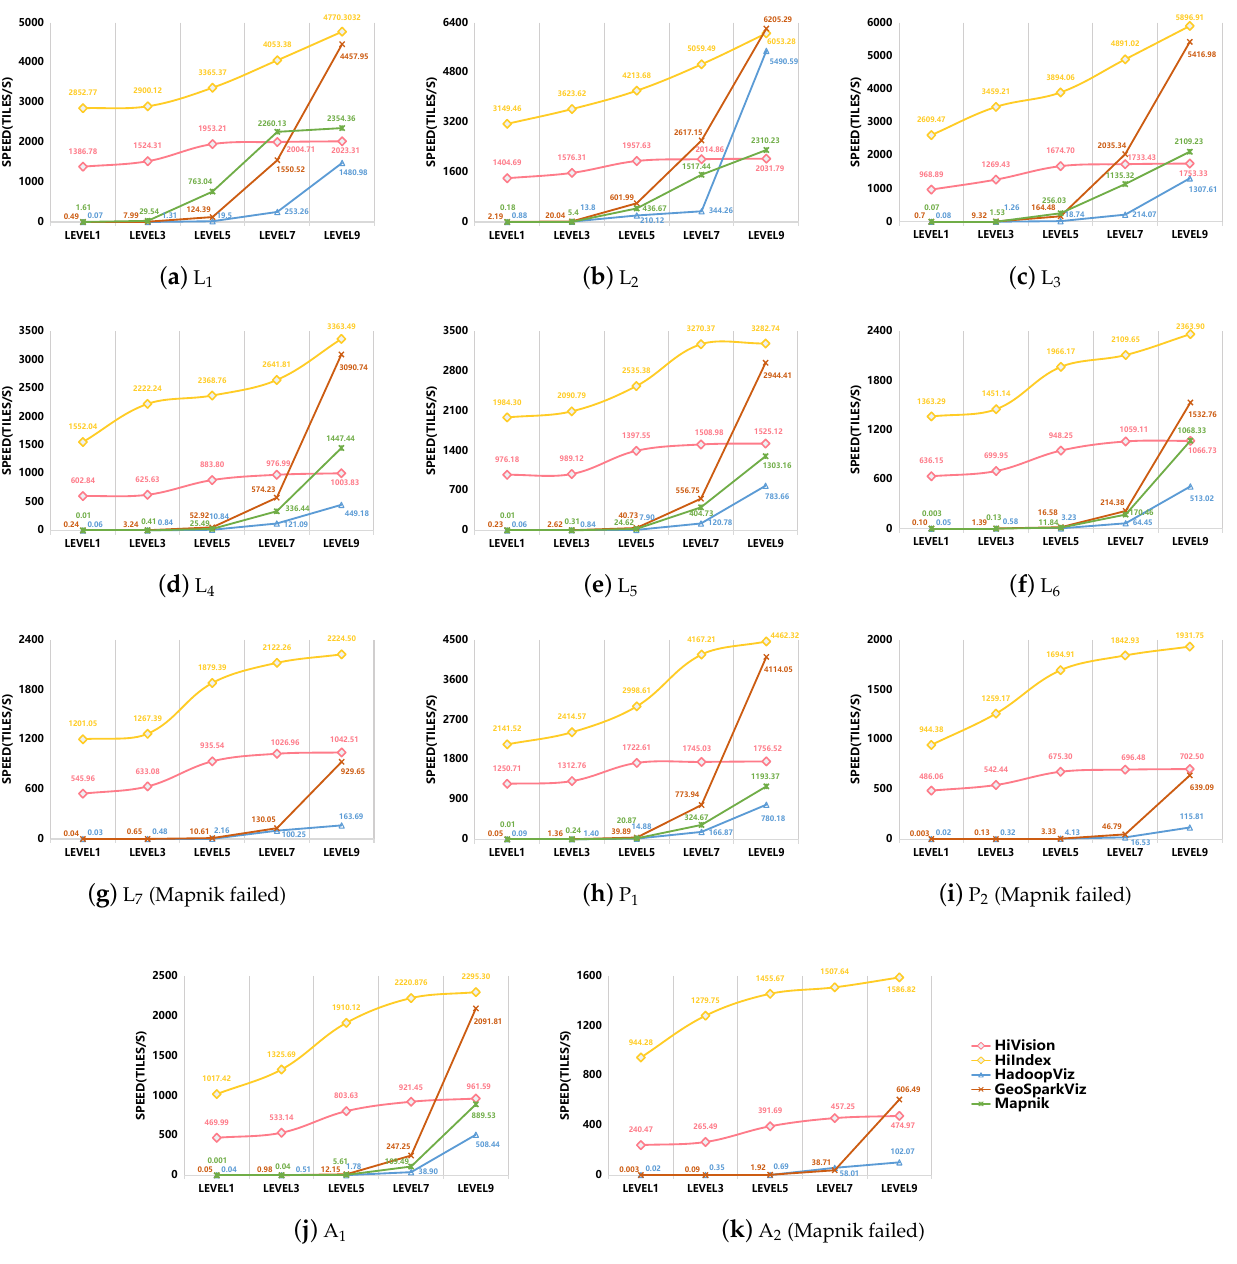
Figure 11. Tile rendering speed of different zoom